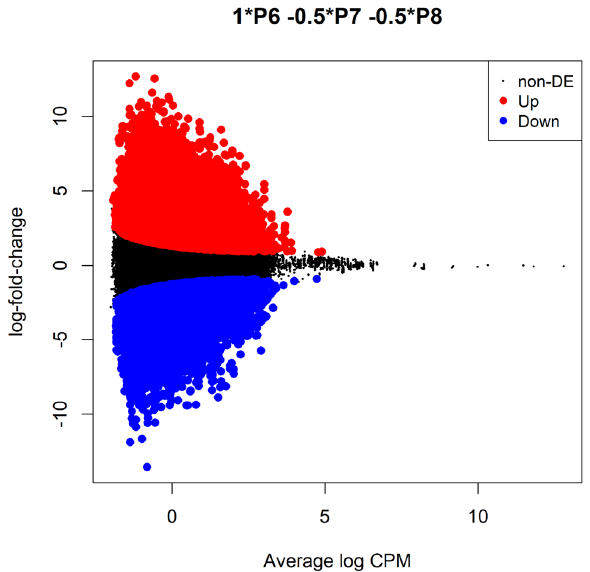
Figure 2. MD plot showing the log-fold-change of the methylation level and average abundance of each CpG site. Significantly hyper- and hypomethylated CpGs are highlighted in red and blue,